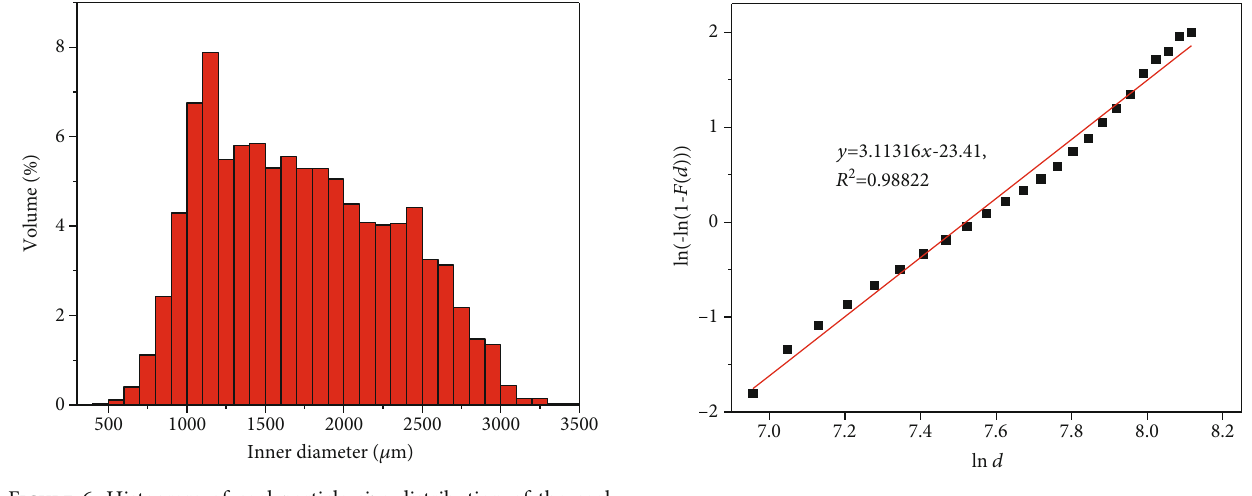
Figure 7: Experimental data and fi tting